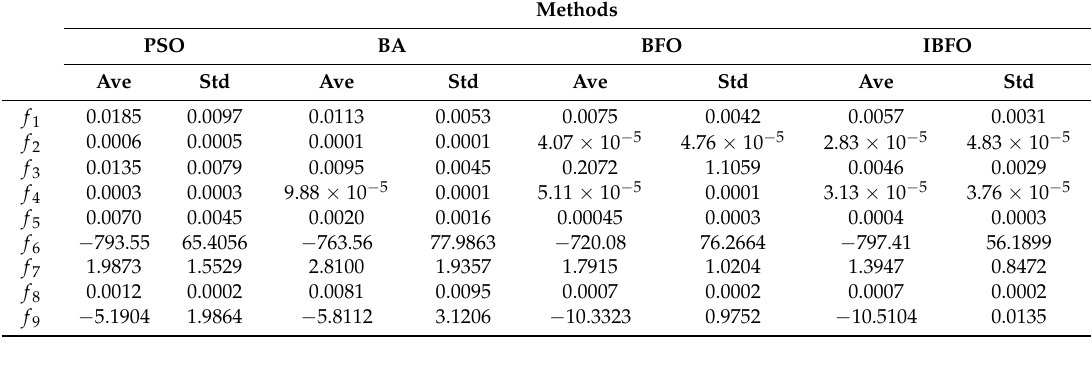
Table 3. Results of testing nine multidimensional benchmark functions.